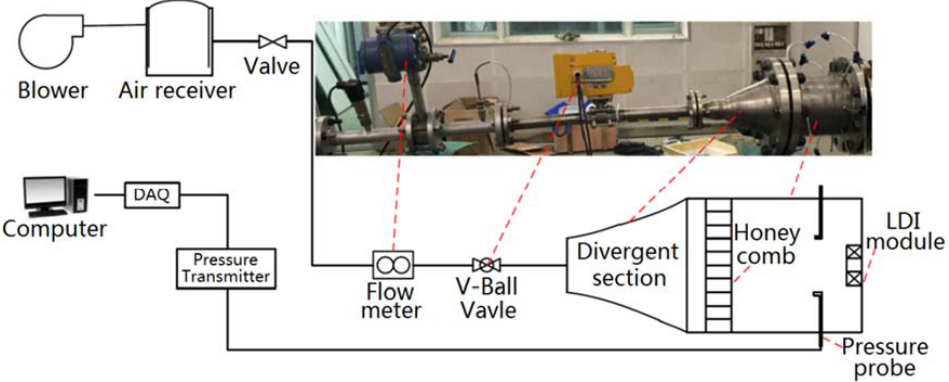
Figure 3. The schematic of test rig.